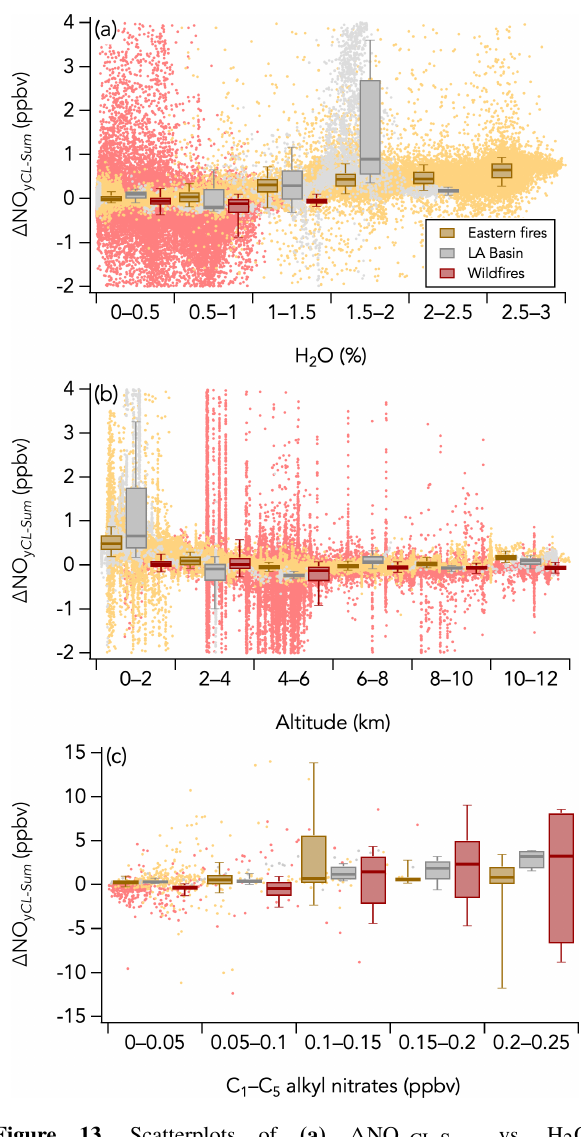
Figure 13. Scatterplots of (a) (cid:49) NO y CL-Sum vs. H 2 O, (b) (cid:49) NO y CL-Sum vs. altitude, and (c) (cid:49) NO y CL-Sum vs. C 1 – C 5 alkyl nitrates measured by the iWAS instrument for three sampling periods during FIREX-AQ (wildfires sampling period in red, eastern fires sampling period in yellow, and Los Angeles (LA) Basin flights in grey). The box and whisker plots show the 10th, 25th, 50th, 75th, and 90th percentiles of (cid:49) NO y CL-Sum distributions in each bin. The dots are the 1Hz data in panels (a) and (b) and 1Hz data averaged to match the iWAS sampling time in panel (c)